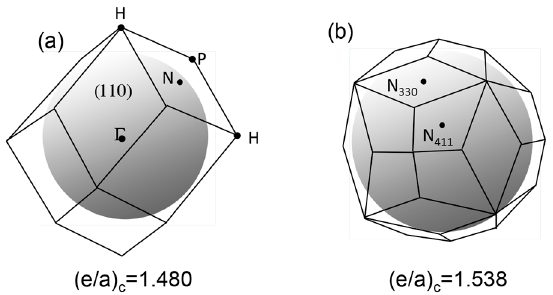
Figure 5. The FsBz interaction in the Mott and Jones theory [3,11,14,19]. A critical value of ( e/a ) c is obtained when the Fermi sphere touches the zone plane of the respective Brillouin zones: ( a ) symmetry points N in the bcc Brillouin zone and ( b ) the symmetry points N 330 and N 411 in the bcc Brillouin zone for the gamma-brass structure. Note that the distance from the origin to the points N 330 and N 411 in ( b ) √ 18 2 π 2 π is the same and equal to in units of , where a is the lattice constant. a 2 a